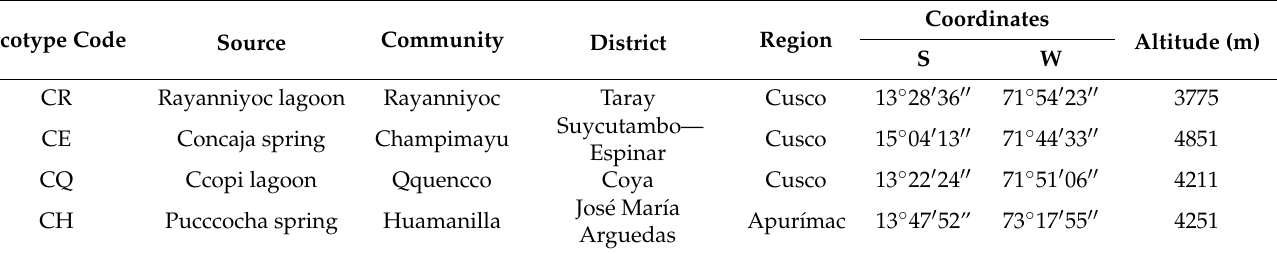
Table 1. Nostoc collection